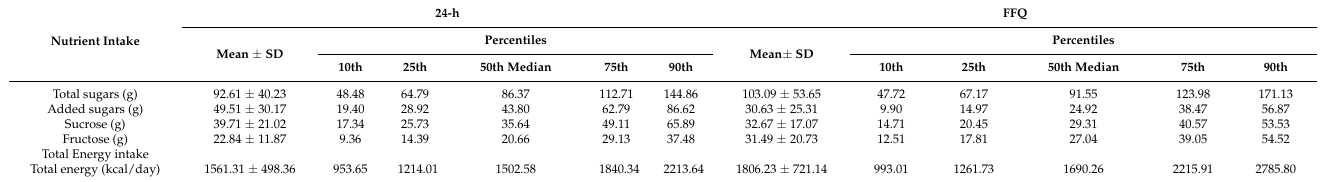
Mean intake of total energy, total sugars, and fructose (Table 2) were higher in the FFQ than in the 24-h recalls, whereas added sugars and sucrose were higher in the 24-h recalls compared to the FFQ. These differences were reflected across most percentiles. Scatter plots representing the correlations between FFQ and recall measurements for each sugar are provided as Supplementary Figure S1. Table 2. Means, standard deviation, and 10th, 25th, 50th,75th, and 90th percentile distribution for total sugars, added sugars, fructose, and sucrose intake per day assessed by FFQ and multiple 24-h recall ( n = 904). 24-h FFQ Percentiles Percentiles NutrientIntake Mean ± SD Mean ± SD 10th 25th 50thMedian 75th 90th 75th 90th Totalsugars(g) 92.61 ± 40.23 48.48